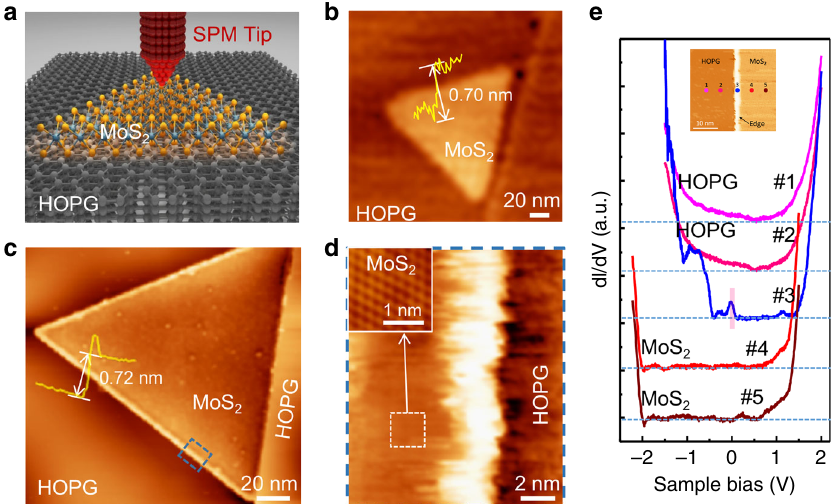
Fig. 2 SPM characterization of monolayer MoS 2 islands on HOPG. a Schematic of SPM measurements process. b AFM image of a typical triangular MoS 2 island, showing no obvious brightness differences between the edge and the bulk. The pro fi le line (yellow) shows an apparent height of 0.70 nm of the triangular fl ake, corresponding to the single-layer MoS 2 feature. c STM image of the triangular MoS 2 island grown alongside the edge of the substrate terrace, clearly showing the electronic edge states with a brim of very high conductance along the island edges. The pro fi le line (yellow) also shows a signi fi cant protrusion at the edge. The apparent height of the triangular fl ake is 0.72 nm, consistent with the AFM measurement in b . d Zoomed-in STM image of the area indicated by the dark-blue rectangle in c . Inset: atomic resolution image of MoS 2 obtained from the area indicated by the white dashed square. e d I /d V spectra taken across the MoS 2 edge from HOPG to the bulk MoS 2 . The color of the curves is consisted with the color of marked positions in the inset. The tunneling spectrum (#3) acquired at the MoS 2 edge shows clearly electronic states (marked by pink) around Fermi level, revealing its metallic feature. STM scanning parameters: U = − 1.0 V, I = 100 pA ( c ) and ( d ) U = − 1.0 V, I = 800 pA for the